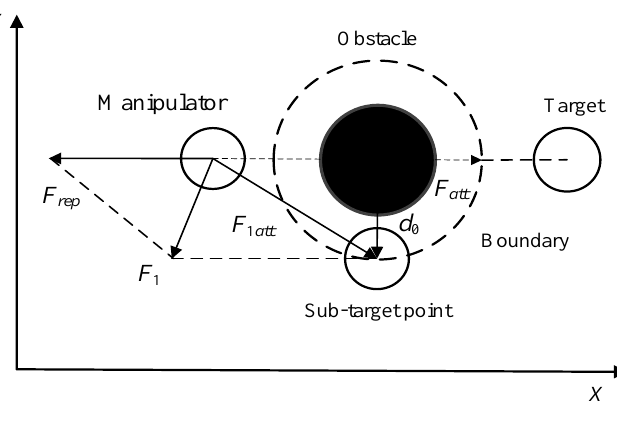
Figure 11. Force of improved local minimum value.